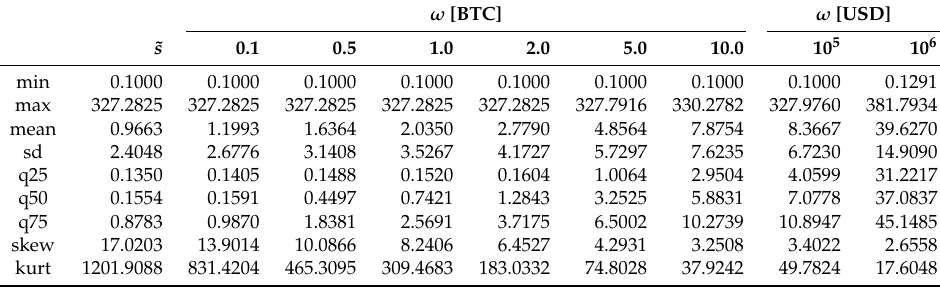
Table 5. Descriptive statistics of liquidity cost measures. We list descriptive statistics of the bid-ask spread ˜ s and volume-weighted average price spreads ˜ vs for different order volumes ω